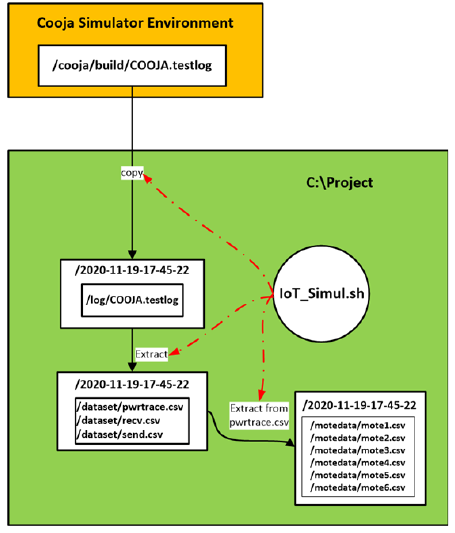
Figure 10. An overview of the process followed by the “IoT_Simul.sh” file to extract all the required “powertrace” information from the “COOJA.testlog” file.